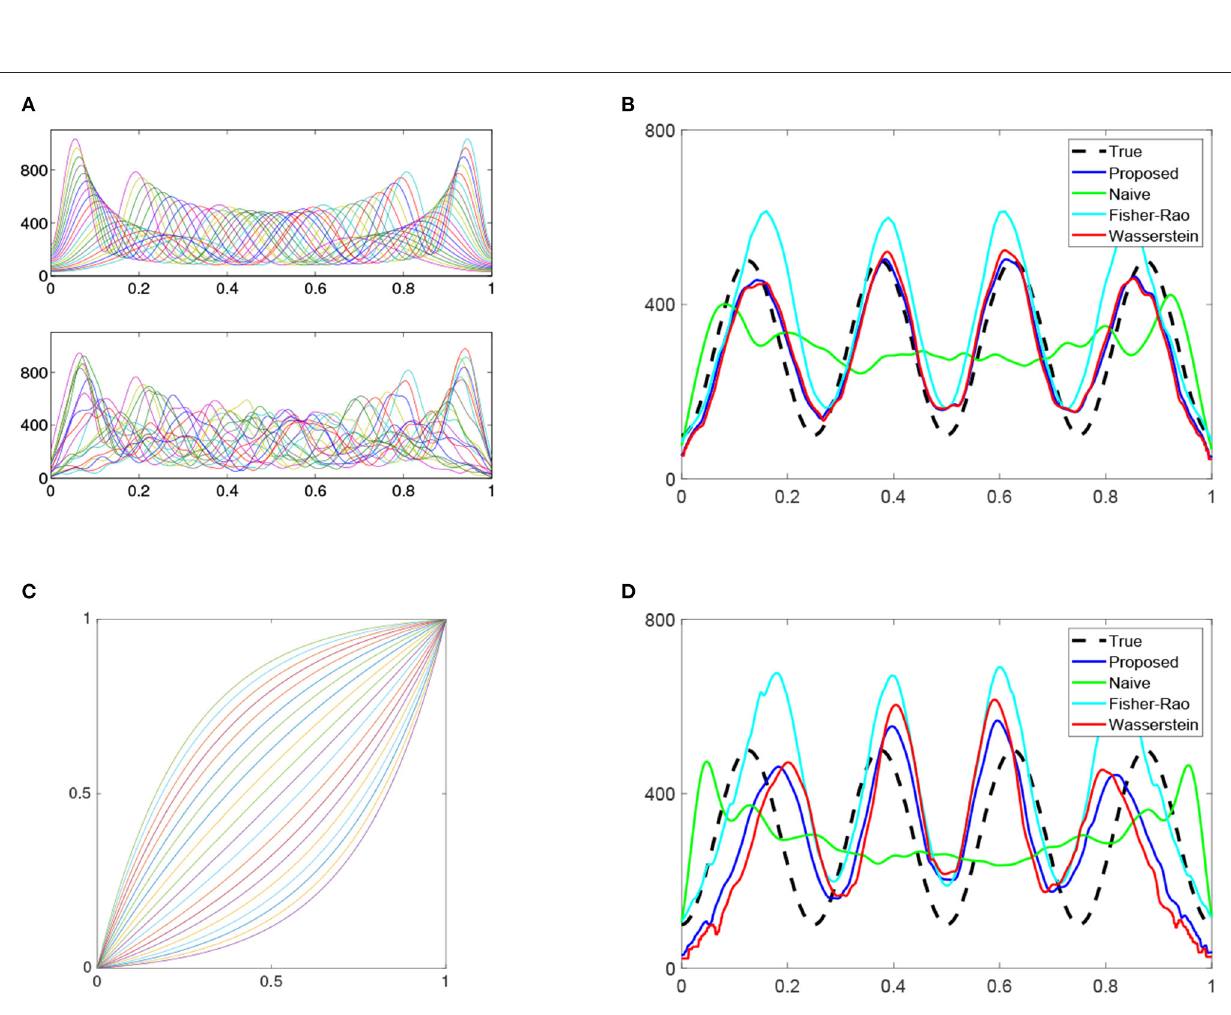
FIGURE 4 | Intensity estimation. (A) Top panel: True warped density functions. Bottom panel: estimated individual density functions using warped processes in Figure 3C . (B) True and estimated intensity functions using four methods: proposed, naive, Fisher-Rao, and Wasserstein. (C) More drastic warping functions in the 2nd Simulation. (D) Same as (B) except for the 2nd